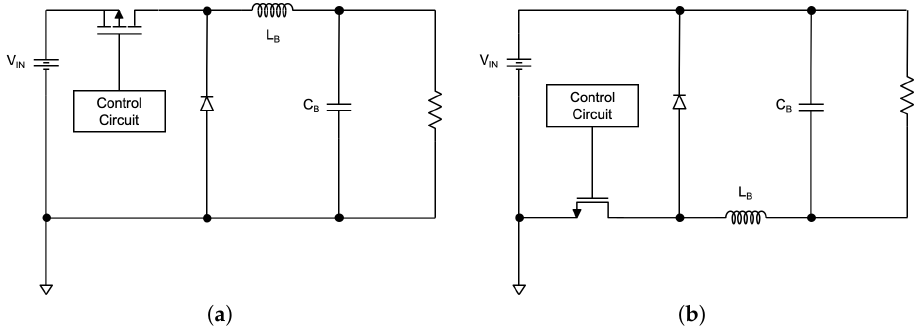
Figure 2. Comparison of schematics for ( a ) conventional buck converter and ( b ) floating buck converter.